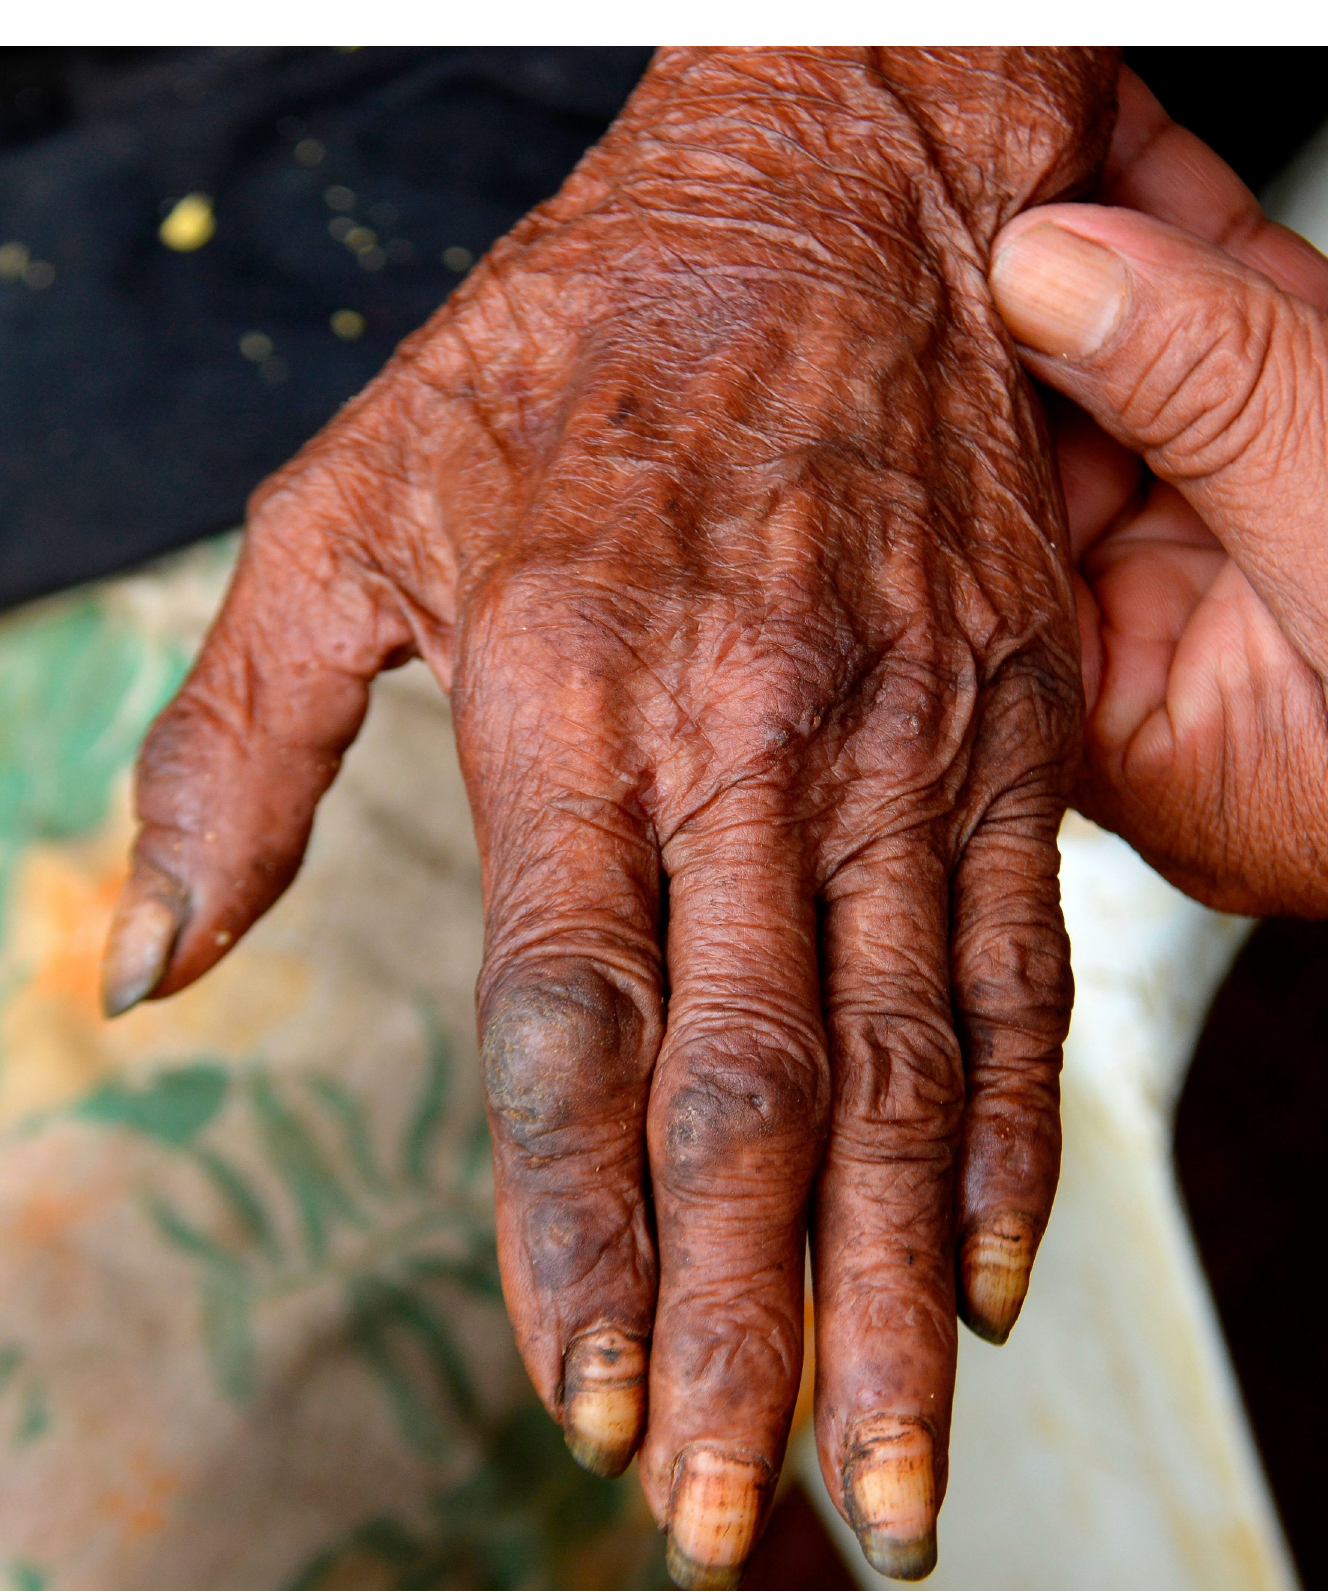
PLOS NeglectedTropical Diseases | https://doi.org/10.1371/journal.pntd.0007068 February 7,